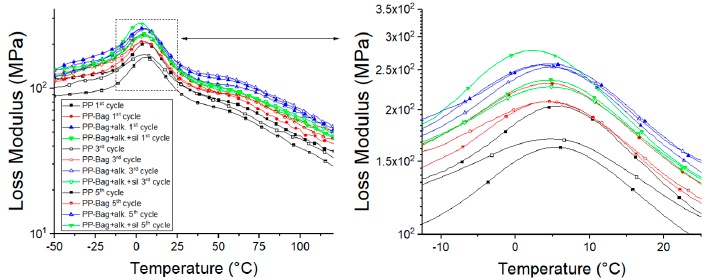
Figure 14. Temperature dependence of loss modulus of PP and their biocomposites.